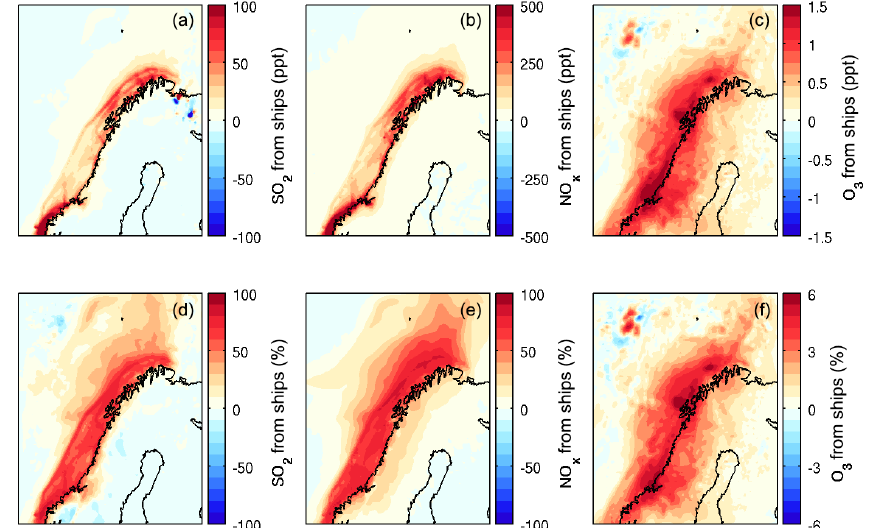
Figure 9. 15-day average (00:00UTC 11 July 2012 to 00:00UTC 26 July 2012) of (top) absolute and (bottom) relative surface enhancements (CTRL – NOSHIPS) in (a, d) SO 2 , (b, e) NO x , and (c, e) O 3 due to ship emissions in northern Norway from